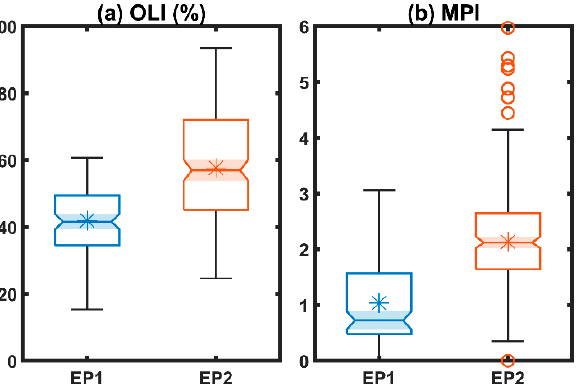
Figure 11. Comparison of two proposed indices––( a ) overlap index (OLI) and ( b ) merging potential index (MPI)––between EP1 and EP2. The boxplot style is similar to that in Figure 1. The asterisk symbol within the box denotes the sample average.